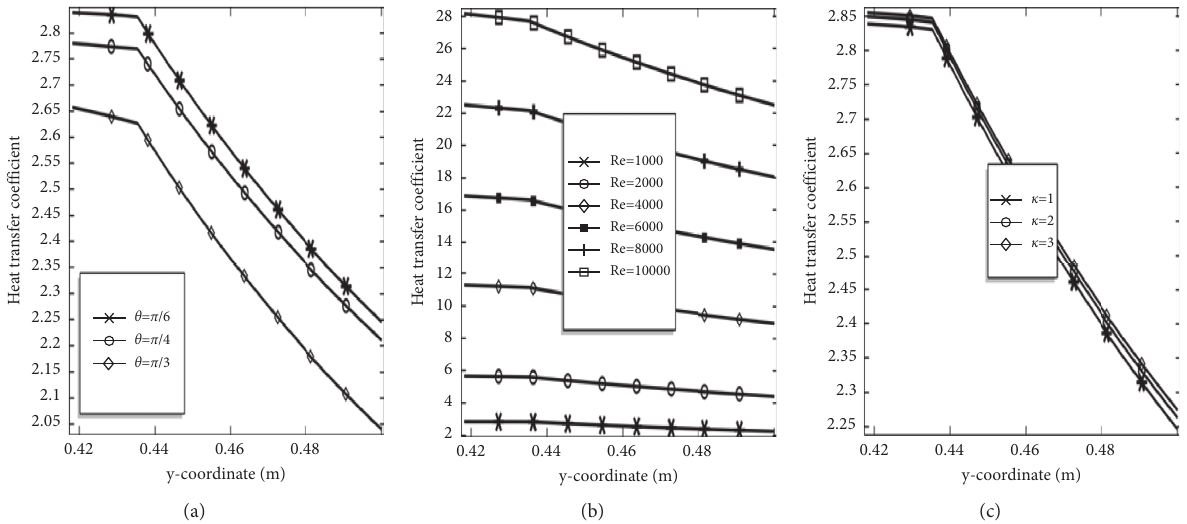
Figure 7: Heat transfer coefficient on the front surface of the circular cylinder (a) for all angles by fixing Re � 1000 and κ � 1; (b) for all Re by fixing κ � 1 and θ � π /6; (c) for all κ by Re � 1000 and θ � π /6.